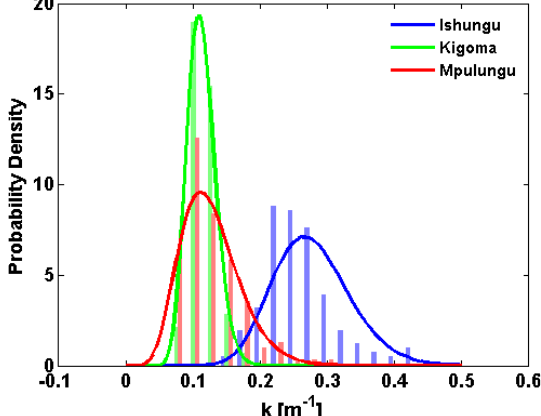
Fig. 3. Comparative histogram of the downward light attenuation coefficient k (m − 1 ) as observed at Ishungu Basin (Lake Kivu) and Kigoma and Mpulungu stations (Lake Tanganyika). Gamma distribution probability density functions are plotted to the data ( R 2 = 0.82, 0.99 and 0.93 for Ishungu, Kigoma and Mpulungu, re-